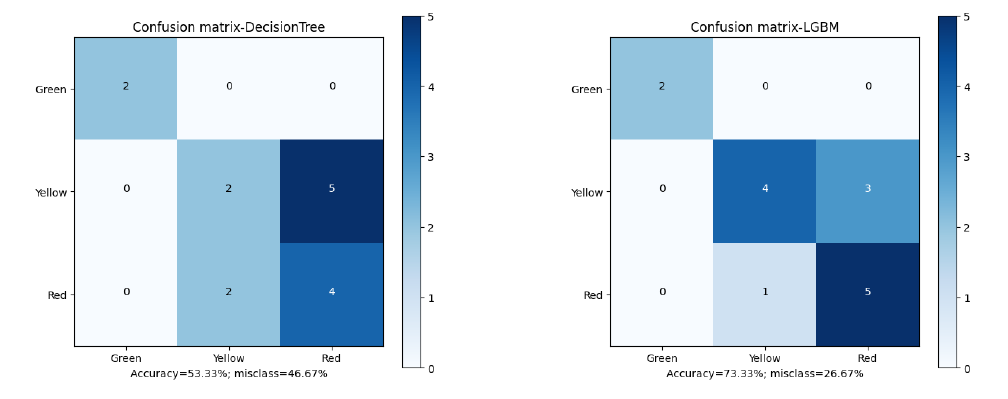
Figure 11. Confusion matrices for Gradient Boosting and Extreme Gradient Boosting classifiers.